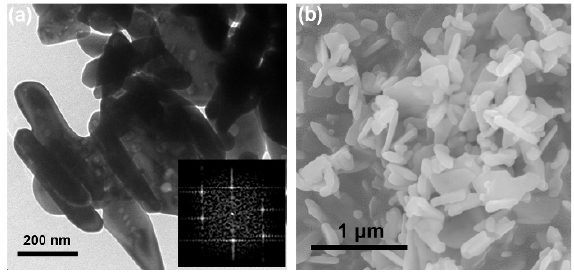
Figure 3. ( a ) TEM images of ZnO 1−x and ( b ) SEM images of ZnO 1−x (insert: FFT of ZnO 1−x ).